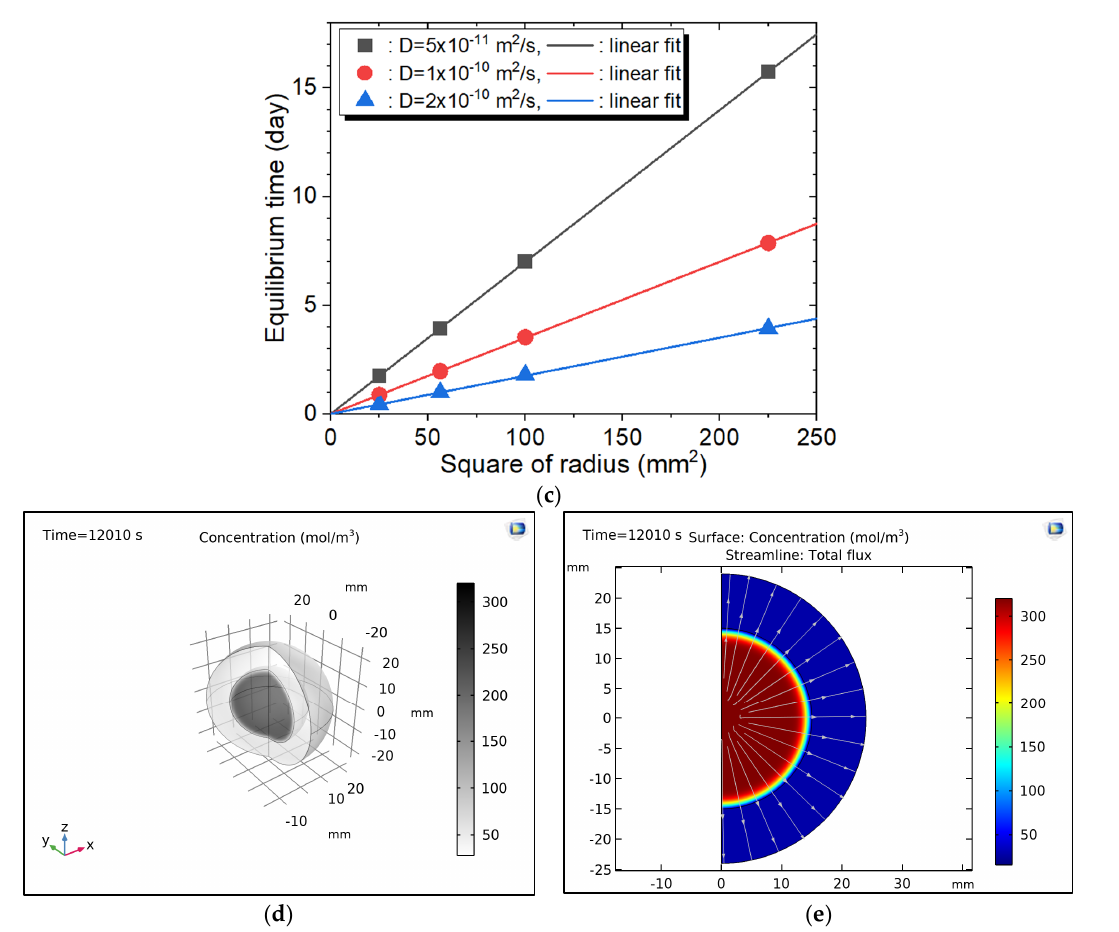
Figure 7. The comparison of the experimental results ( a , b ) and COMSOL simulation results, ( a , c – e ), equilibrium time in sorption and ( b ) equilibrium time in desorption versus the squared radius for NBR, EPDM, and FKM. ( c ) Finite element simulation for the equilibrium time versus the squared radius with diffusivities of 5 × 10 −11 m 2 /s, 10 × 10 −11 m 2 /s, and 20 × 10 −11 m 2 /s; ( d ) a simulation example showing the 3D presentation of the concentration distribution at 12,010 s with a diameter of 30 mm; ( e ) a simulation example showing the concentration distribution at 12,010 s with a diameter of 30 mm.